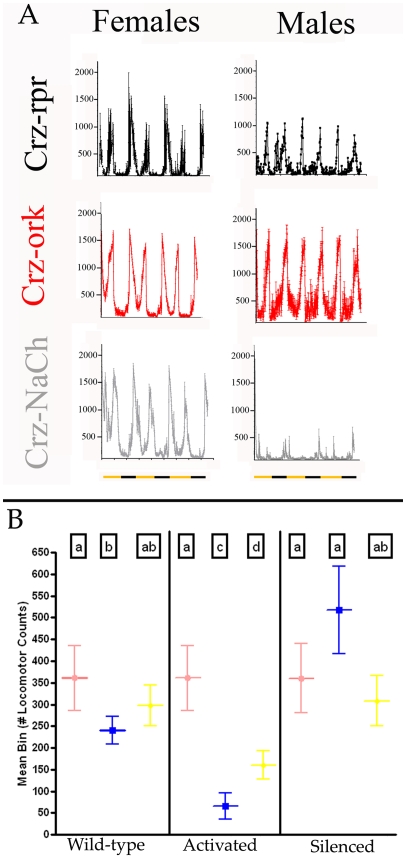
Locomotor activity is differentially affected by corazonin neuron function and sex.
A: Locomotion was monitored for three 12∶12 LD cycles on flies expressing different transgenes in corazonin neurons. Raw data are means +/− SEM from three replicate experiments. Records begin at lights on (ZT0). B: Quantification of total locomotion. Mean amount of locomotion per ten minute bins were estimated for the genotypes listed plotted with 95% confidence intervals are plotted from three independent experiments. Different letters denote statistical significance from each other (Tukey post-hoc test p<0.05). Locomotor values from females are designated in red, males in blue, and for animals with feminized corazonin neurons are indicated in yellow. Animals in the first group have wild-type corazonin neuronal function (w1118), the second grouping are expressing NaChBac in corazonin neurons (Activation) and the third grouping are expressing the ork channel in corazonin neurons (Silencing).